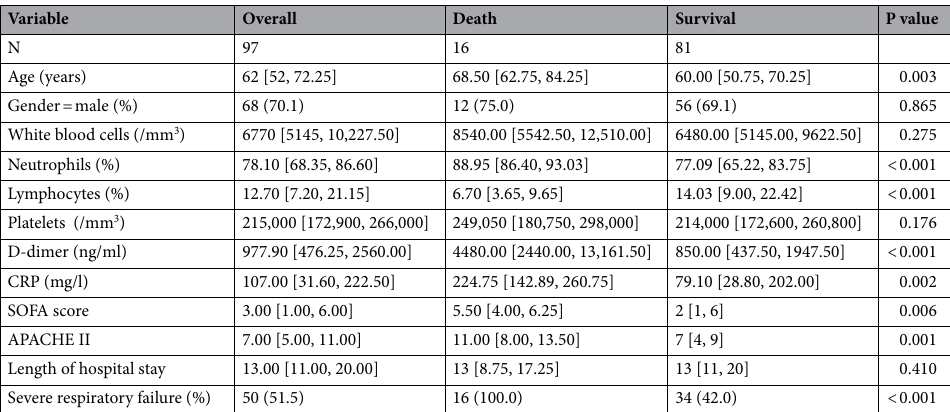
Table 2. Demographics, severity scores, and severity markers for the prospective COVID-19 cohort, overall and split by mortality. P-values correspond to Mann–Whitney tests for difference of means and chi-square tests for difference of proportions between the survival and mortality groups. Unless indicated otherwise, numbers shown are median [IQR].